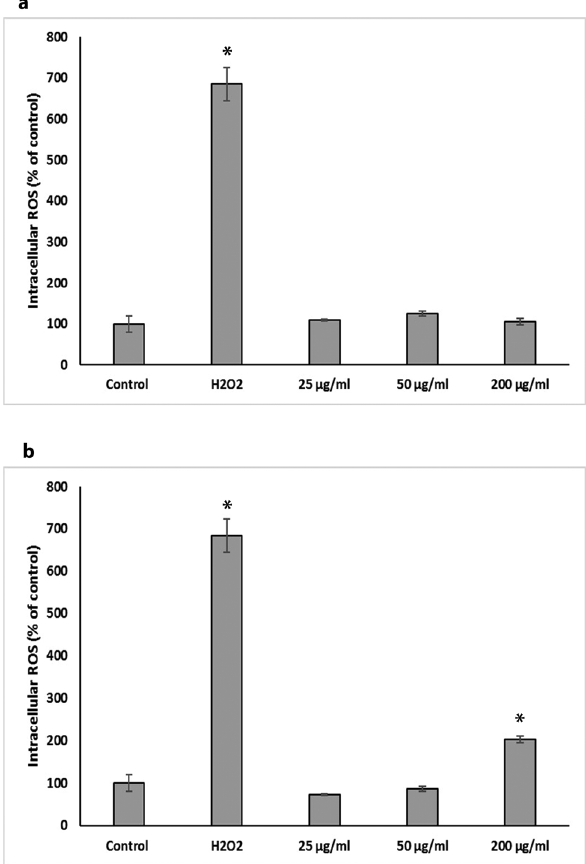
Figure 3: Evaluation of ROS generation in HEK - 293 cells using the fl uorescent probe DCF. Cells were treated with di ff erent concentra - tions of ZnO - NPs ( 25, 50, 200 µM ) and positive control ( 600 µM H 2 O 2 ) for 3 h ( a ) and 24 h ( b ) . Data are expressed as a percent of values of untreated control cells and are means ± SD of three independent experiments. * indicates a statistically signi fi cant di ff erence from corresponding untreated control cells ( p < 0.05 )